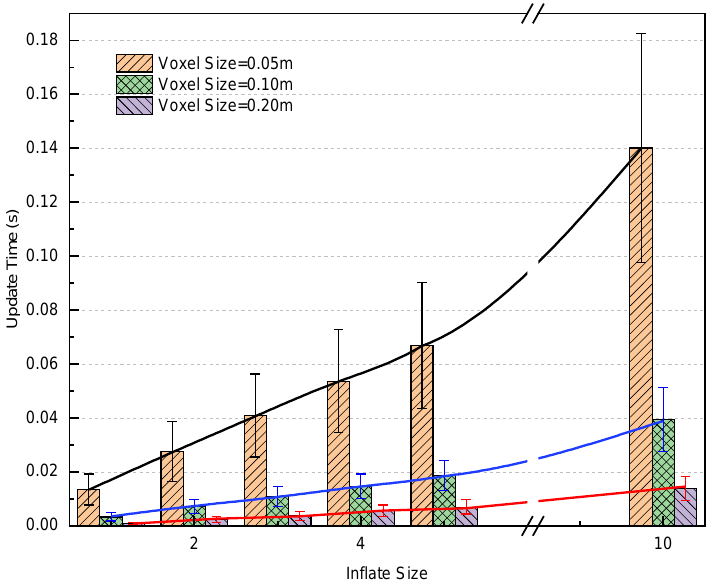
Figure 6. The performance on the laboratory corridor dataset. The sliding map size is set to 100 m × 100 m × 6 m, the connectivity is 6, the ray casting distance and maximum depth is 8 m, and the local update range is 16 m × 16 m × 6 m.